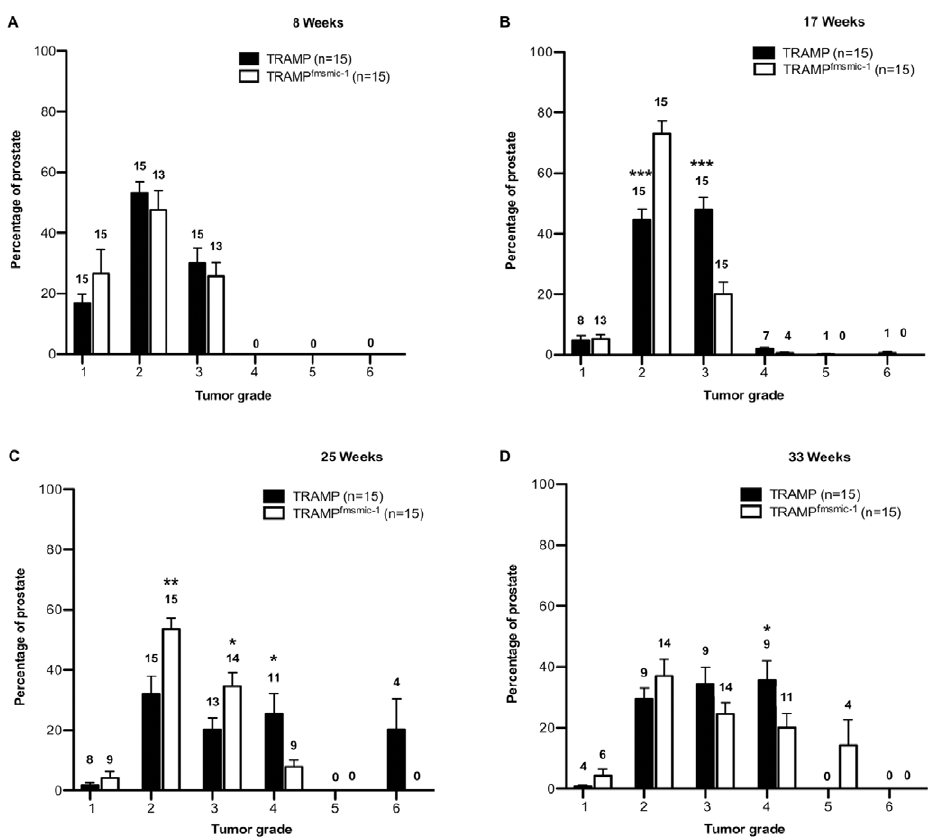
Figure 2. TRAMP fmsmic-1 prostate tumors have lower histological grades. Prostates of 15 TRAMP and 15 TRAMP fmsmic-1 mice were excised at week 8 (panel A), 17 (panel B), 25 (panel C), and 33 (panel D). Serial sections were graded and scores for each grade were averaged for all the mice in the group. The graph represents the mean proportion of the prostate from all the mice in the group having each different pathologic grade, scored between 1 and 6 6 SEM. Numbers on the bars show number of mice in the group having a particular grade. p values are shown as *p , 0.05; **p , 0.01; ***p , 0.001.